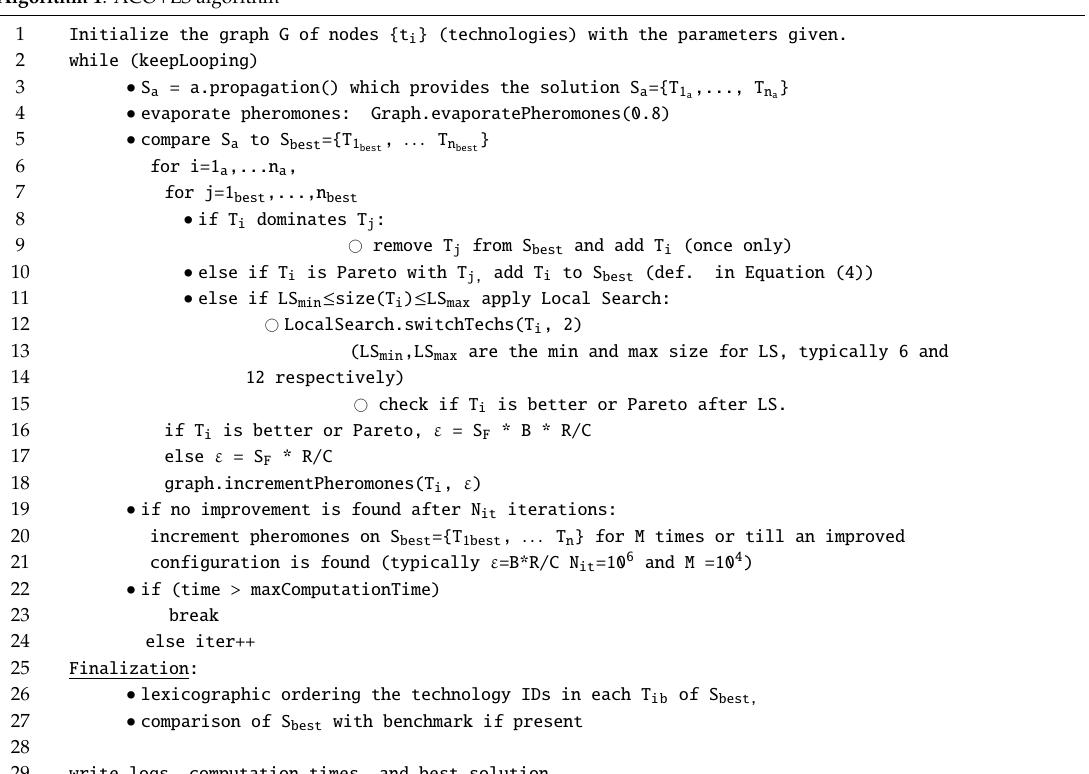
Algorithm 1 . ACO + LS